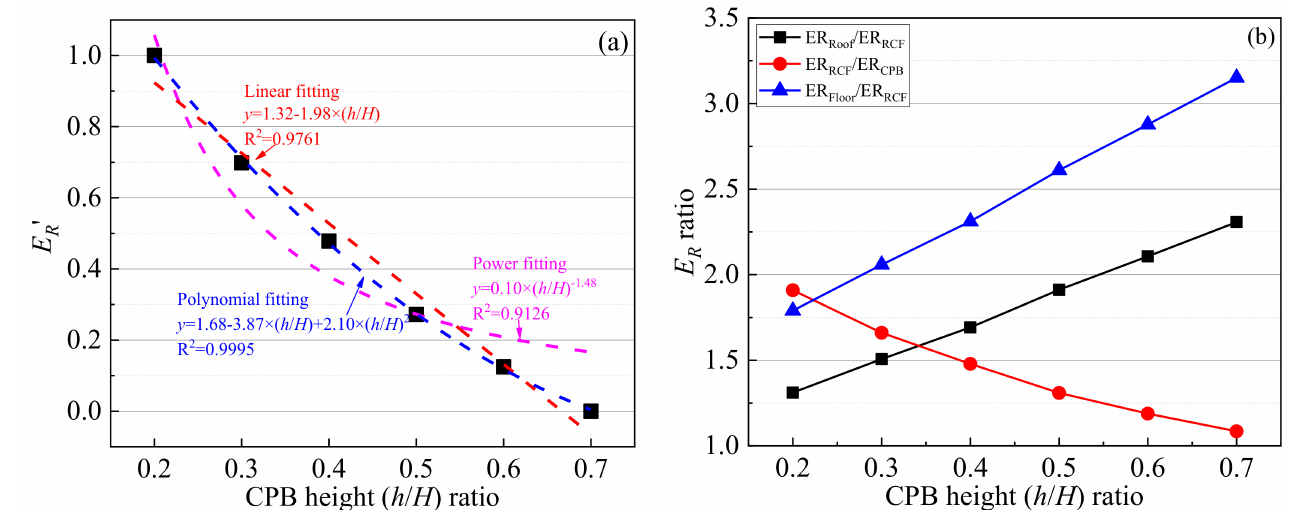
Figure 5. Elastic modulus of RCF material: ( a ) E R and h / H ratio; ( b ) E R ratio and h / H